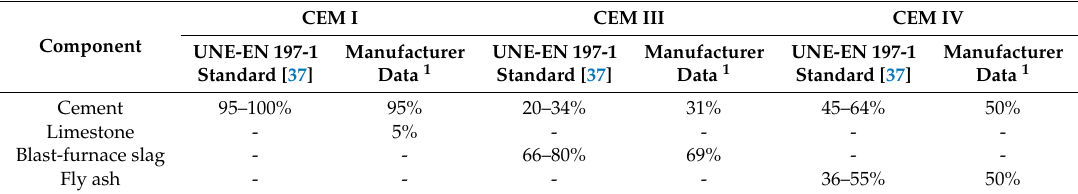
Table 1. Components of the commercial cements used.